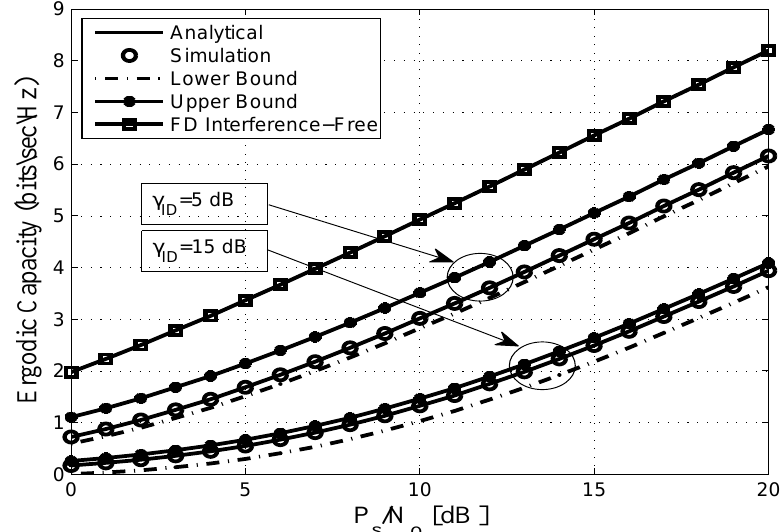
Figure 2. Ergodic capacity vs. P S / N o for different values of γ ID with m ij = 2, d SR = 0.45, d RD = 0.55, γ RR = 5 dB, and η =